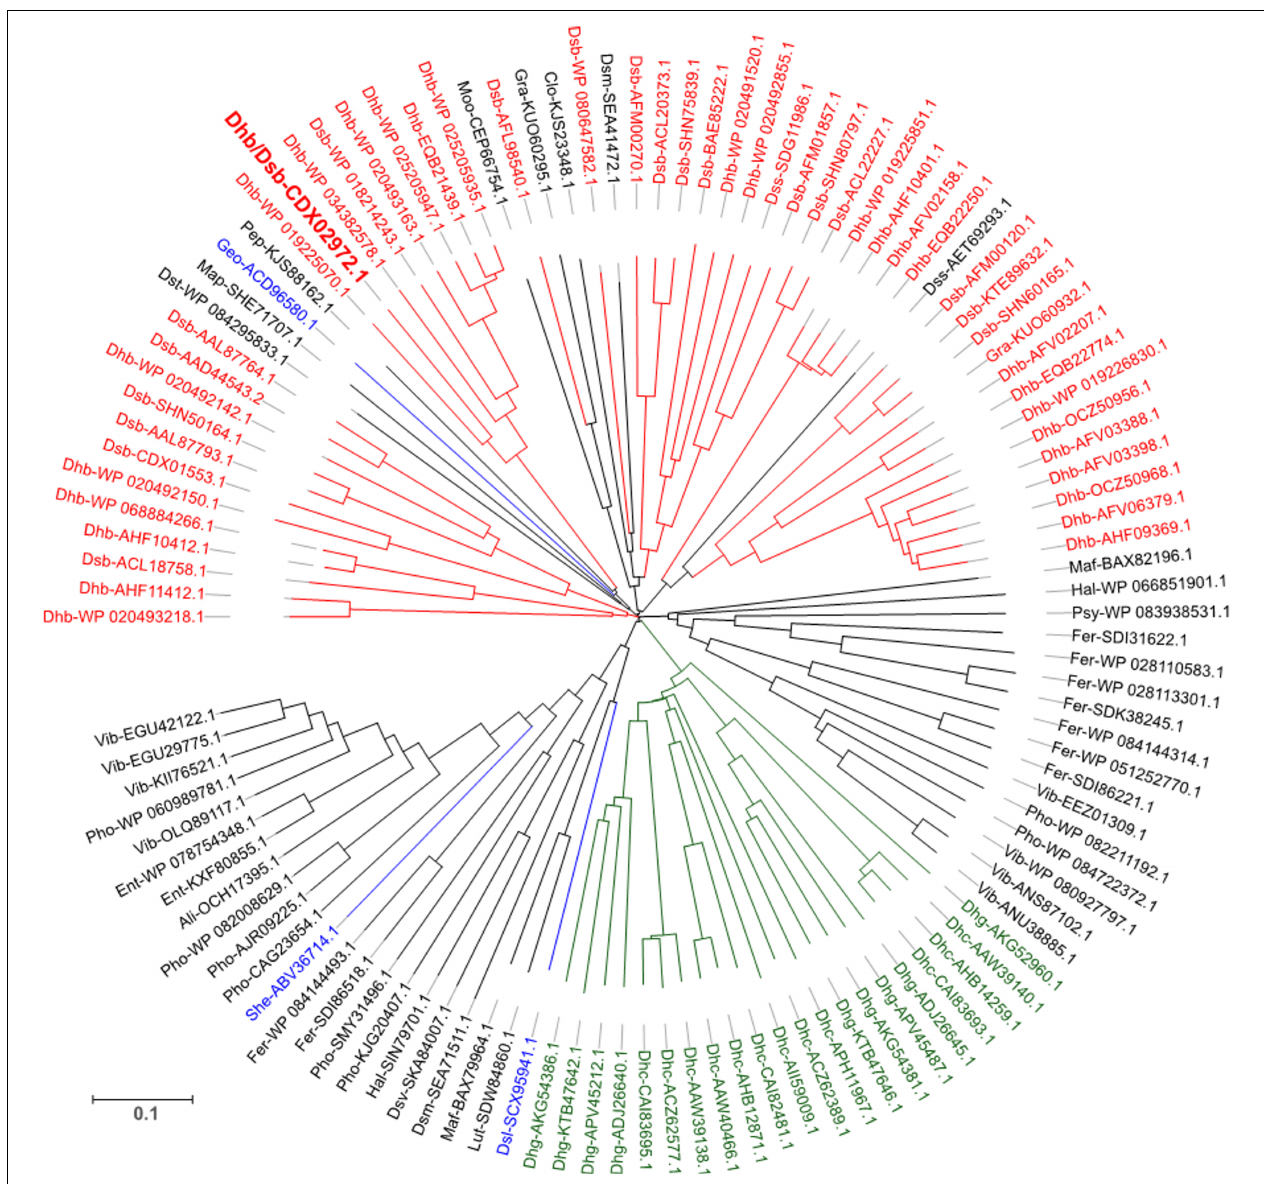
FIGURE 2 | Sequence likelihood analysis of 117 representative RdhC proteins. Sequences are annotated with an abbreviation of the corresponding species followed by the reference number. The sequence annotated in bold red is PceC from Desulfitobacterium hafniense , the representative sequence for the protein under investigation in this study. Colors indicate sequences belonging to well-described OHR bacterial genera: red, Dehalobacter and Desulfitobacterium ; green, Dehalococcoides and Dehalogenimonas ; blue, additional OHRB. Detailed information on the overall database used is available in Supplementary Material (Supplementary Table